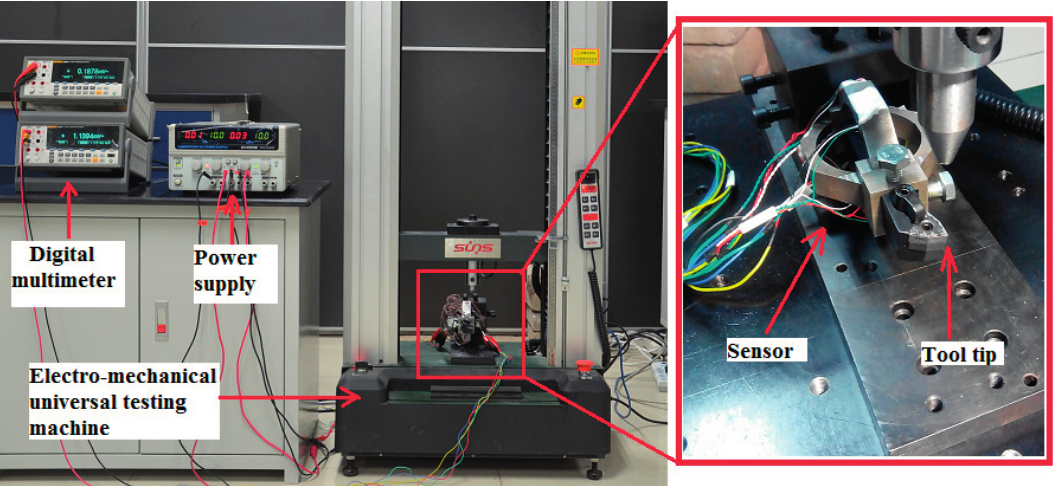
Figure 6. Experimental setup for static